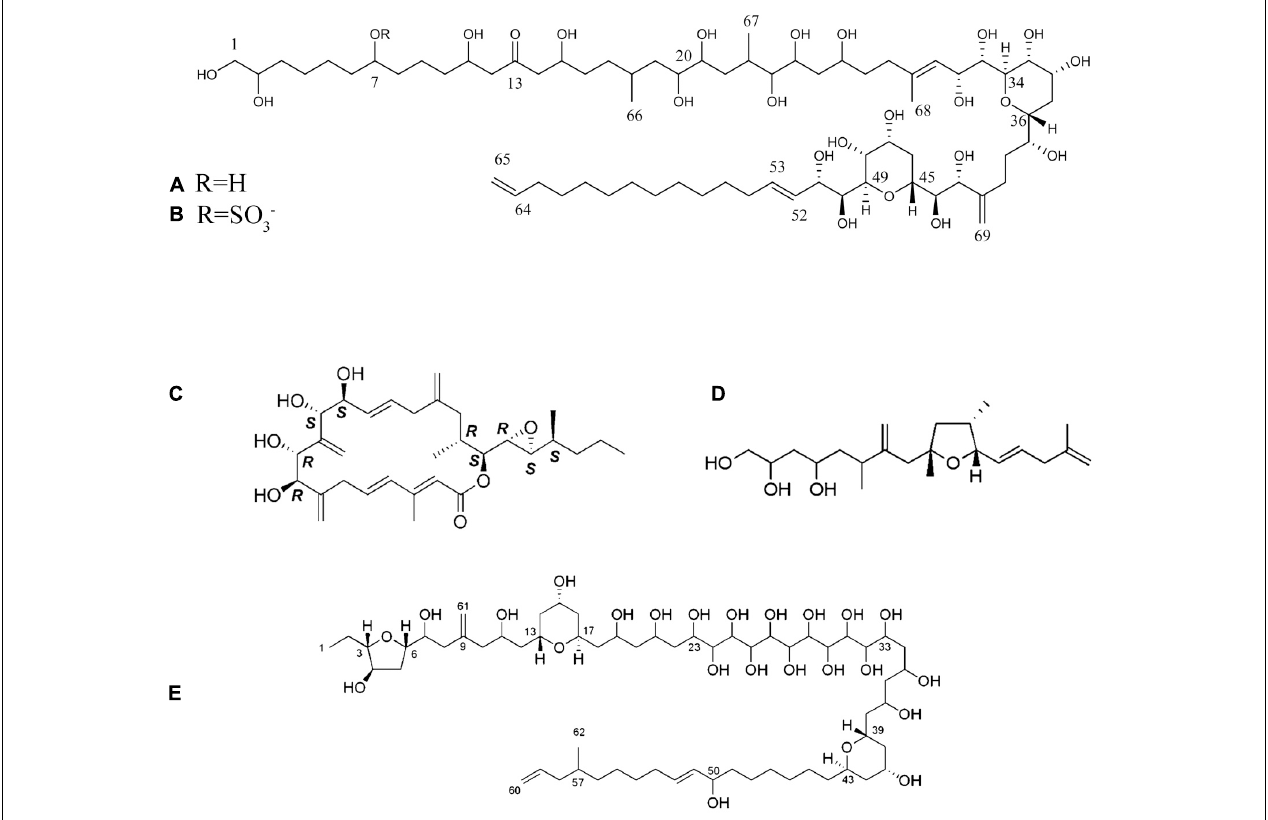
FIGURE 4 | (A,B) Amphidinols A and B; (C) Amphidinolide A; (D) . Amphidinin; (E) Amphezonol (Kobayashi and Kubota, 2007; Cutignano et al., 2017). Reprinted with permission from Kobayashi and Kubota (2007).